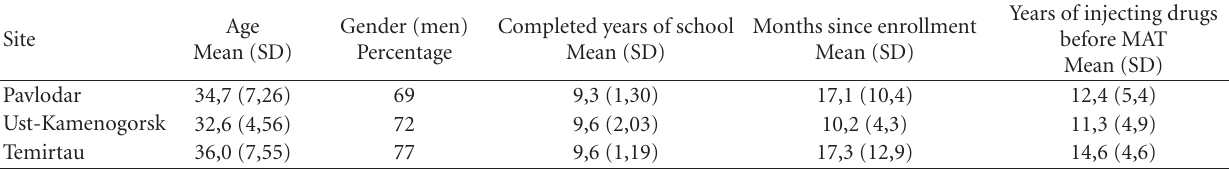
Table 1: Characteristics of MAT patients who participated in interviews.